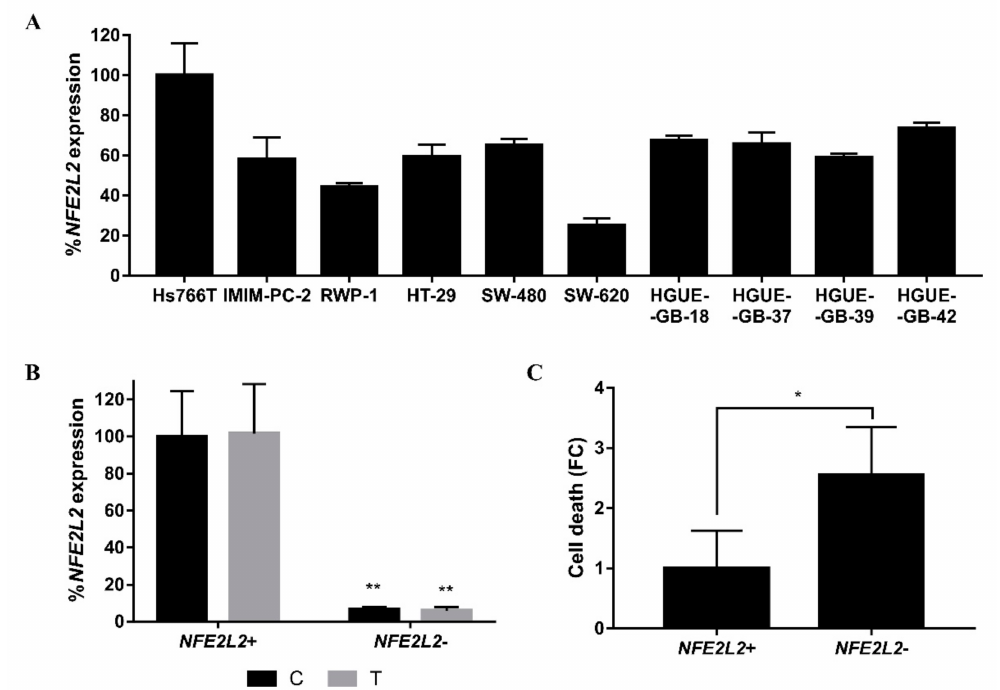
Figure 7. Role of NFE2L2 in the resistance to CLytA-DAAO-induced cell death. ( A ) NFE2L2 expression in all pancreatic and colon carcinoma and glioblastoma cell lines previously studied. Data represent the percentage of NFE2L2 expression, normalized with respect to Hs766T ± SD with n ≥ 3. ( B ) NFE2L2 expression levels in Hs766T cell line, control (C) and treated (T) with CLytA-DAAO and D-Ala, after being transfected with a non-specific ( NFE2L2 + ) or an NFE2L2 siRNA ( NFE2L2 − ). Data represent the percentage of NFE2L2 expression, normalized with respect to control transfected with a non-specific siRNA ± SD with n ≥ 3. ( C ) Fold change (FC) of Hs766T cell death after being treated with CLytA-DAAO and D-Ala for 24 h and transfected with a non-specific ( NFE2L2 + ) or an NFE2L2 siRNA ( NFE2L2 − ). Data represent the cell death increase ± SD with n ≥ 3. * indicates a p -value < 0.05 and ** p -value <